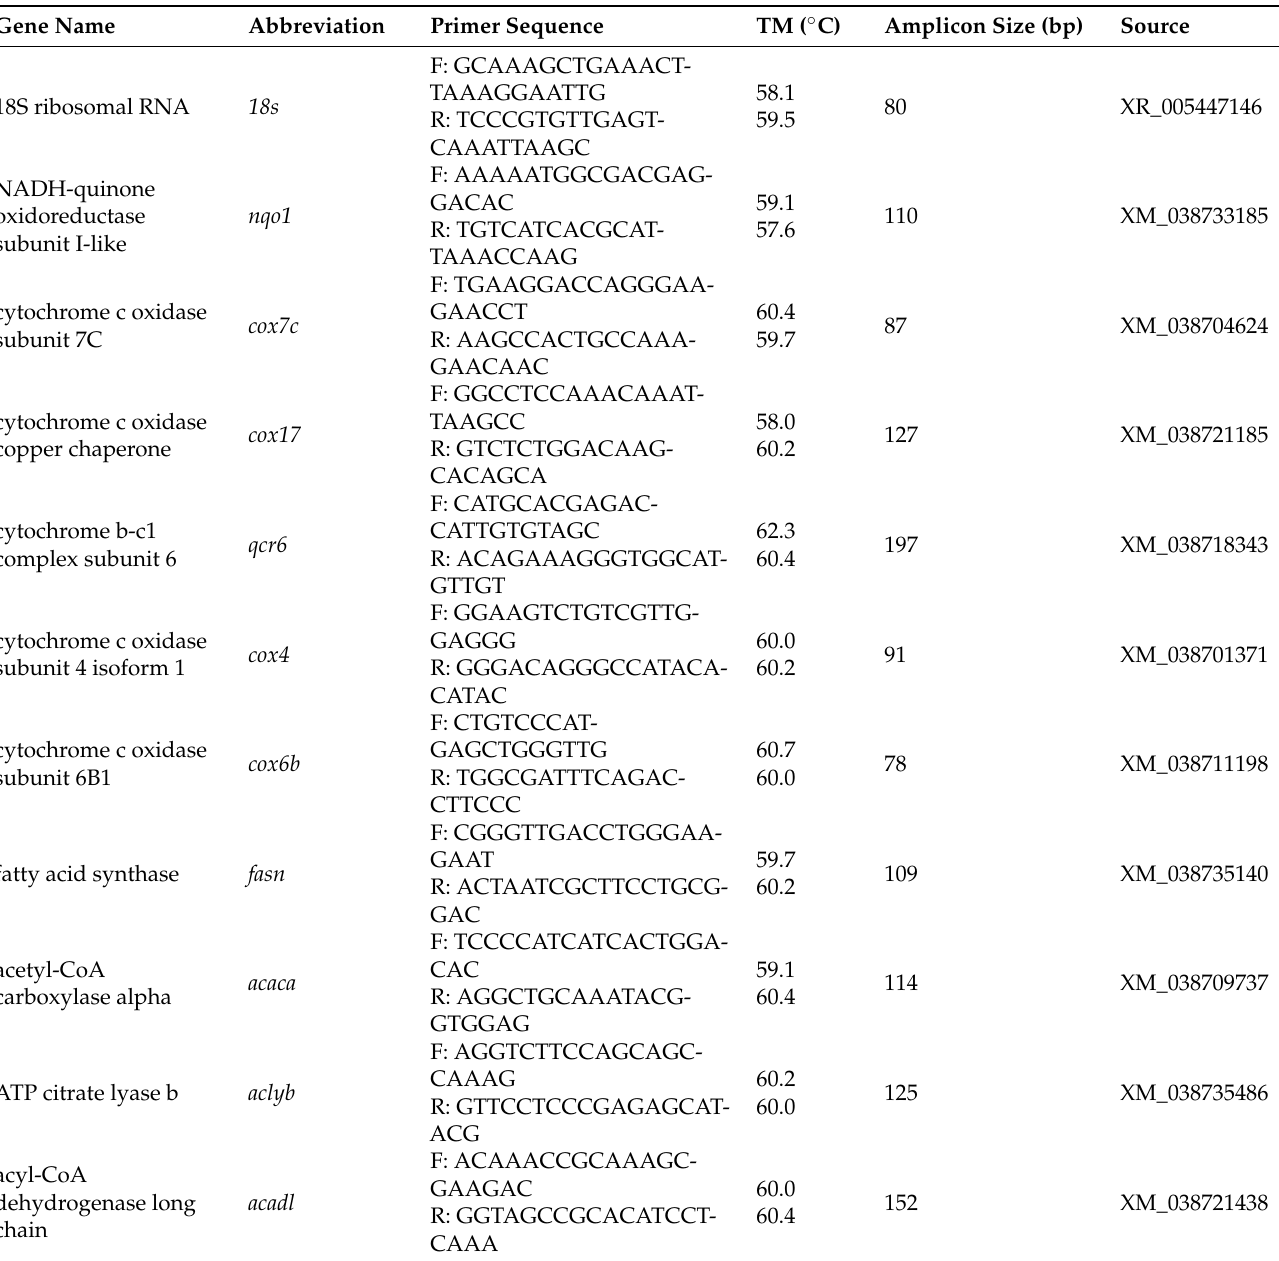
Table 1. Primers used in the present